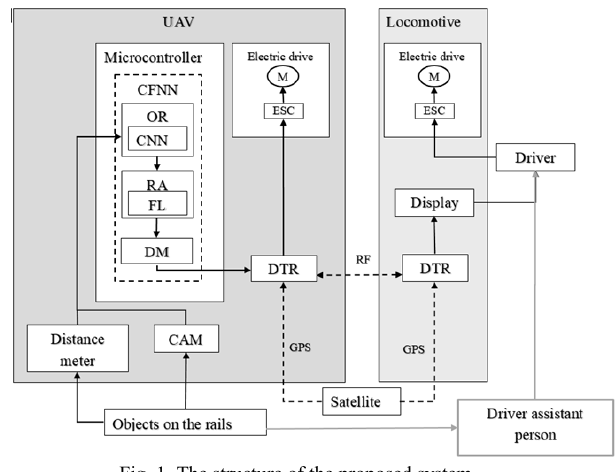
Fig. 1. The structure of the proposed